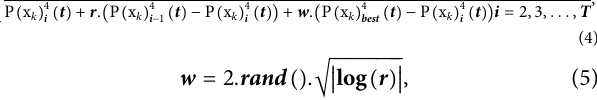
Figure 3 is a fl owchart for the entire optimization procedure discussed